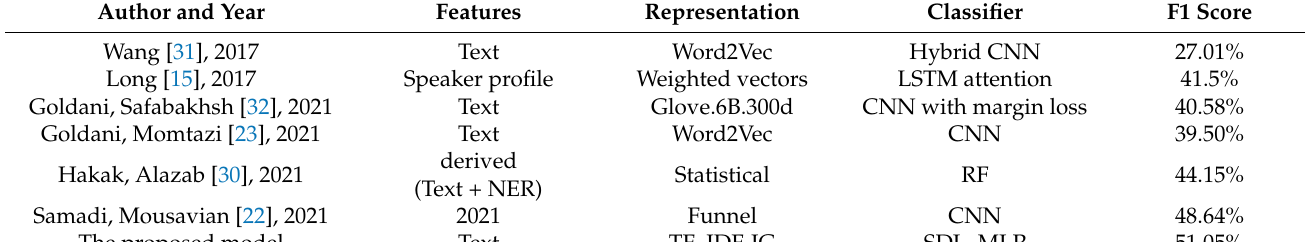
Table 4. Classification Accuracy of the Models using LIAR dataset.